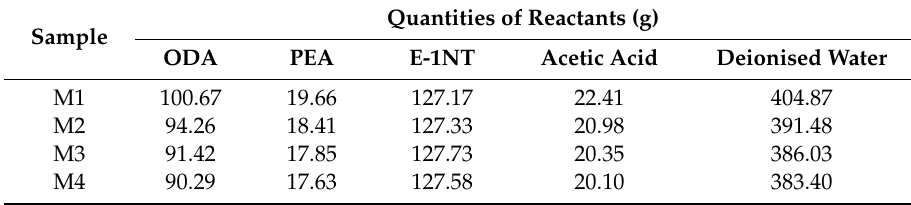
Table 1. Quantities of reactants for sizing emulsions with four di ff erent molecular